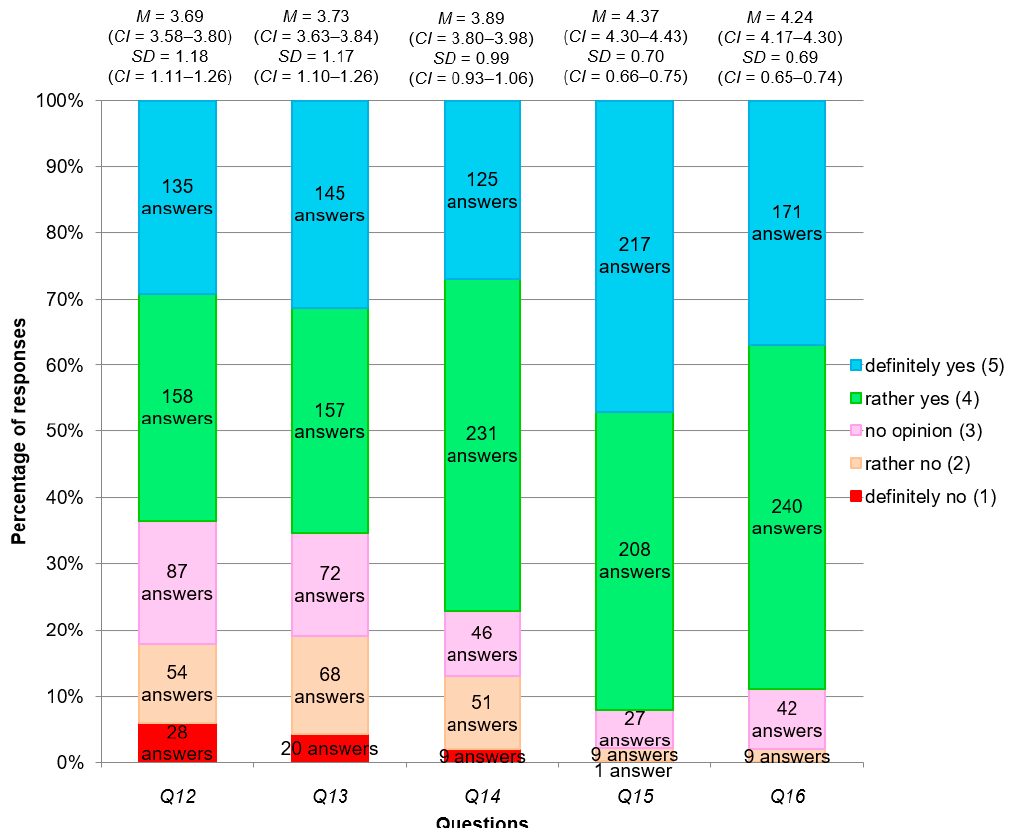
Figure 8. Assessment of factors determining energy saving for heating water in residential buildings ( M —average, SD — standard deviation, CI —confidence interval; questions numbers ( Q ) according to the Appendix A).